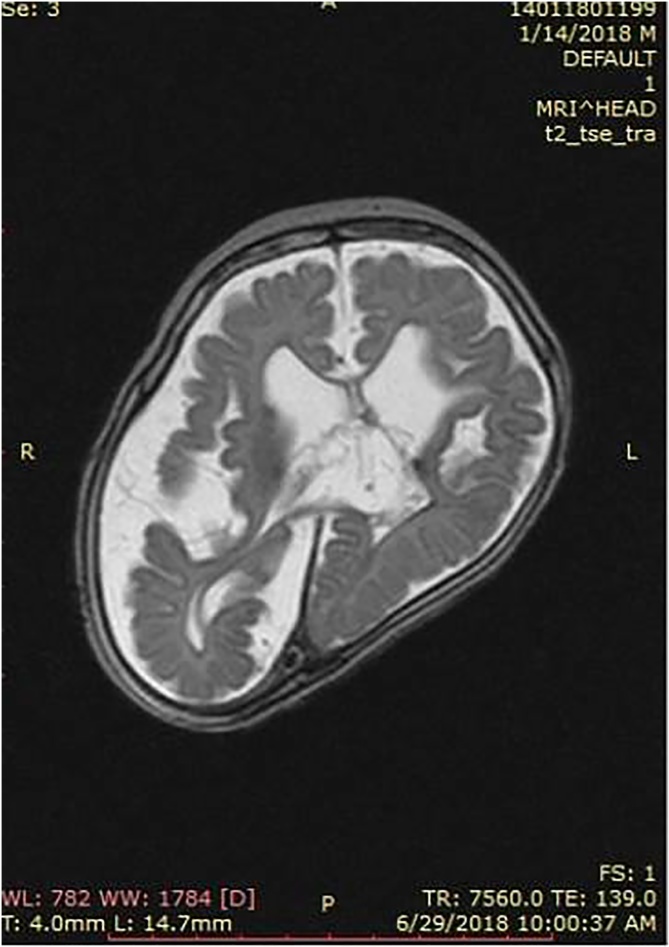
MRI scan, axial view, demonstrating reduction of the size of the ventricles with a degree of dilation of the subarachnoid spaces.